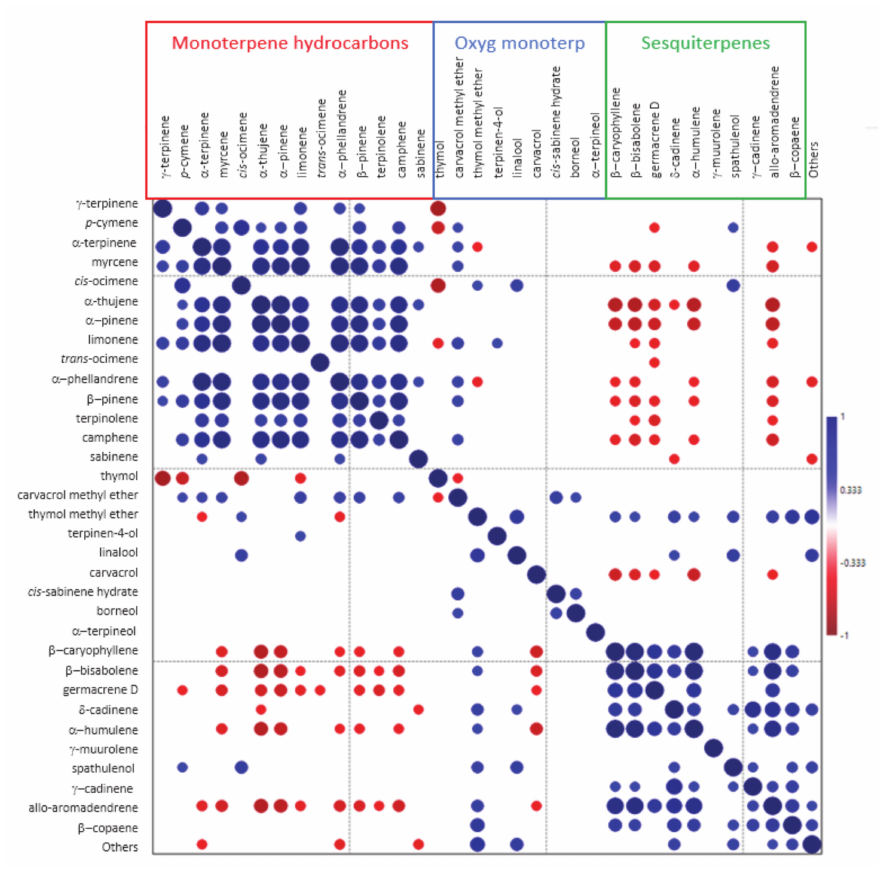
Figure 3. Correlation (Pearson’s r ) plot of the major compounds detected in EO from Origanum heracleoticum cultivated in Sicily from 2013 to 2015 in 3 locations ( n = 54). Positive and negative correlations are displayed in blue and red, respectively. Size and color intensity are proportional to the correlation coe ffi cients. r values having significance values p > 0.05 were left